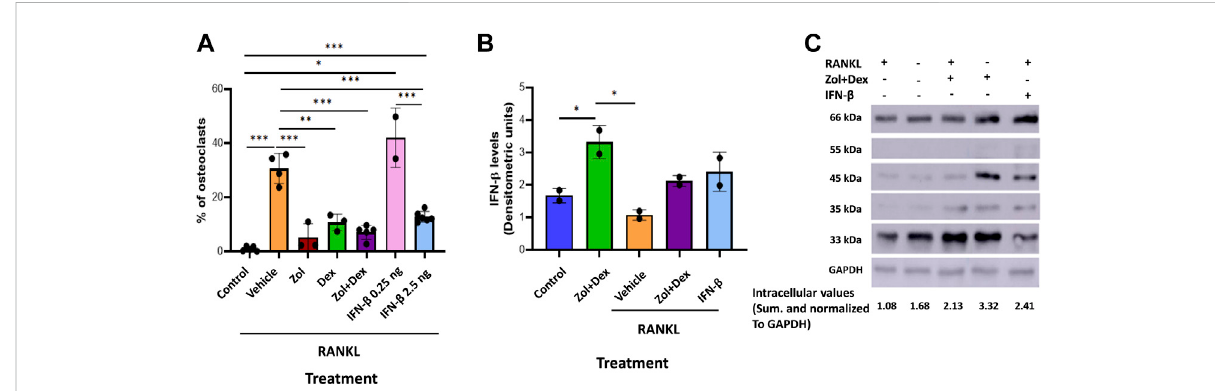
FIGURE 3 Zol+Dex and IFN- β inhibitRANKL-induced osteoclastogenesis. (A) Macrophages weretreatedwithRANKLand Zoland/orDex(10 µMeach), or 0.25 – 2.5 ng/ml IFN- β for 48 h to induce osteoclast differentiation (after 5 days). Then, cells were fi xed, stained for TRAP, and image analysis was performedusingtheImageJsoftware. (B) QuantitativeanalysisofmacrophagestreatedwithorwithoutRANKL,Zol+Dex,orIFN- β for24 h.Thecells were harvested, and W.B. for IFN- β was performed. The high molecular weight (more than 33 kDa) species of IFN- β underwent densitometric analysis, and the obtained values for each treatment were summed and normalized to GAPDH. (C) Representative IFN- β blotting image. Statistical signi fi cance by one-way ANOVA between matched treatments is indicated (A – B) . * p < 0.05, ** p < 0.01, *** p < 0.001, **** p < 0.0001 ( n = 2 – 5).